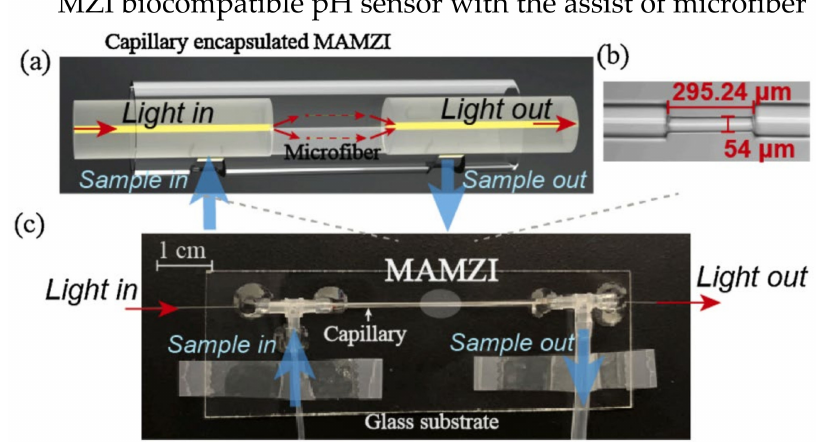
Figure 11. Experiment setup of the biocompatible pH sensor: ( a ) schematic diagram of the MAMZI, two SMF was spliced with a small section of microfiber to form the MZI, the microfiber was spliced with the lower half of the SMF; ( b ) A microscopic image of the MAMZI, showing a tapered diameter of 54 µ m and total length of 295.24 µ m; ( c ) Experimental setup with a microfluidic chip. Reprinted with permission from Ref. [95]. Copyright 2021,